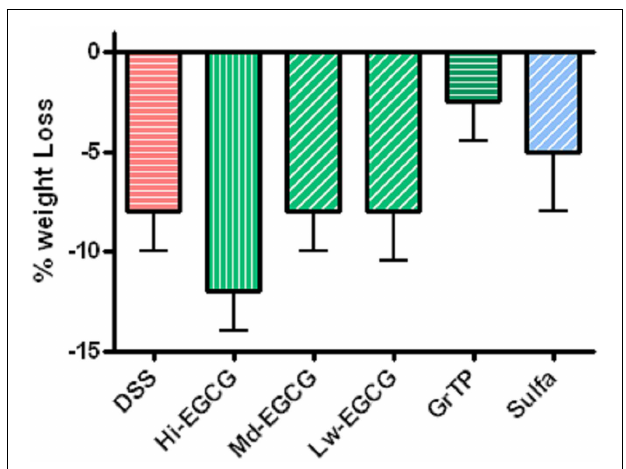
FIGURE 1 | Percent body weight loss in DSS-induced colitis compared to the normal control animals . Colitic mice lost body weight and animals on High dose EGCG therapy showed the most weight loss. Mid and Low doses of EGCG had no effect on body weight. In contrast, GrTP and Sulfasalazine partially improved the body weight